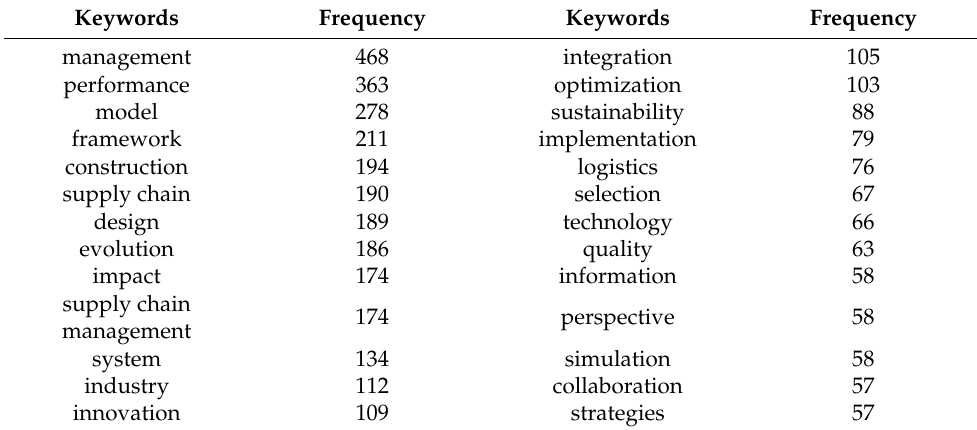
Table 4. High-frequency keywords and their frequency in the field of